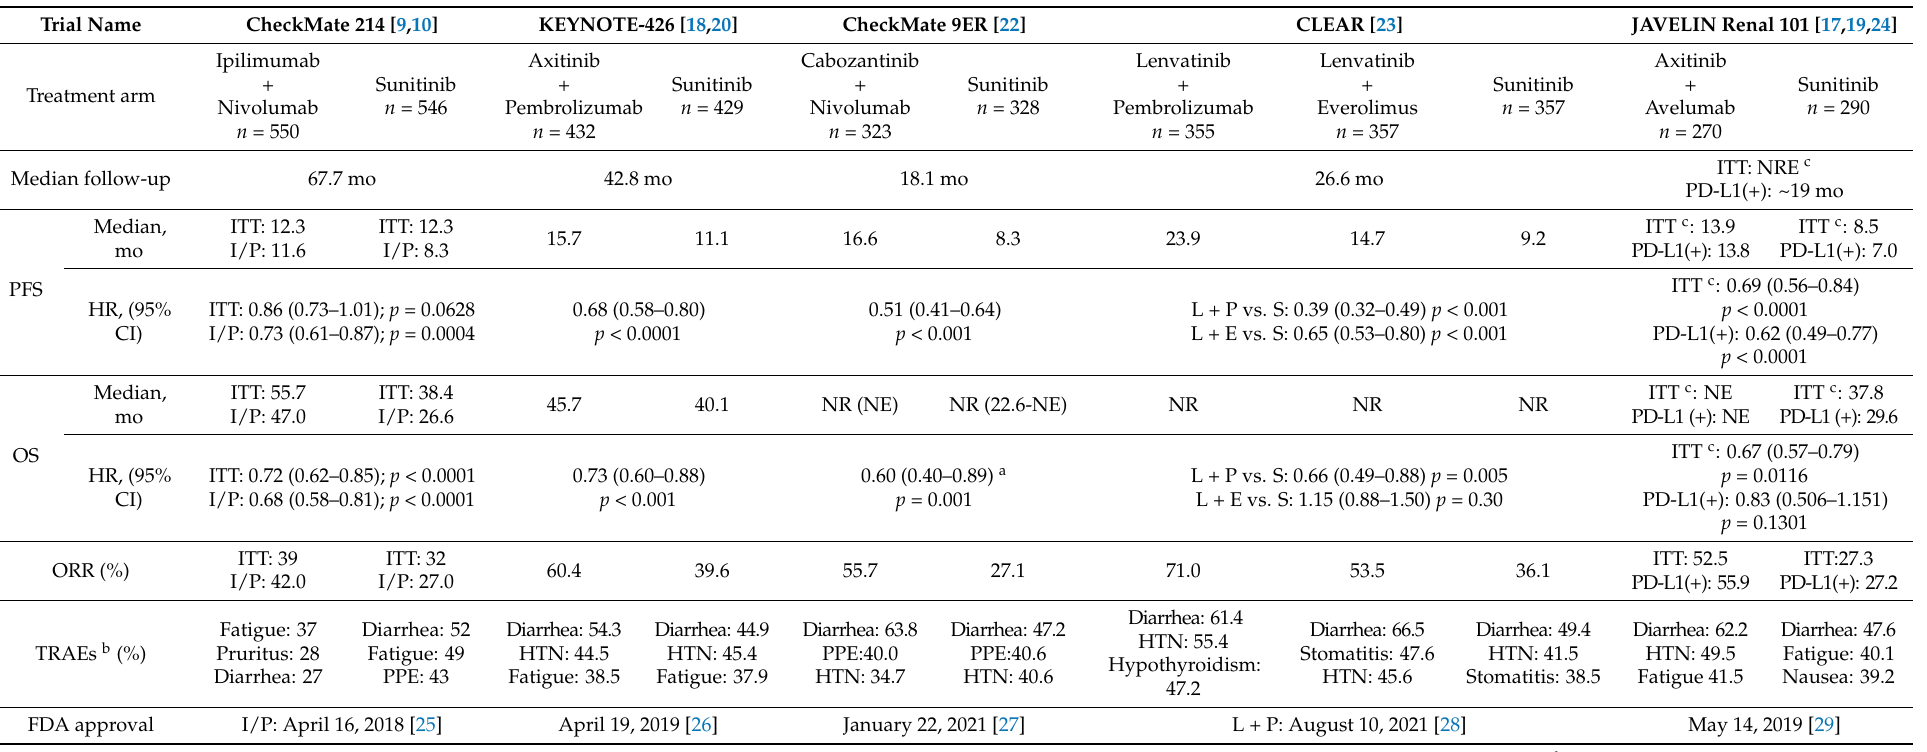
Table 1. Combination Approaches in First-Line Metastatic Renal Cell